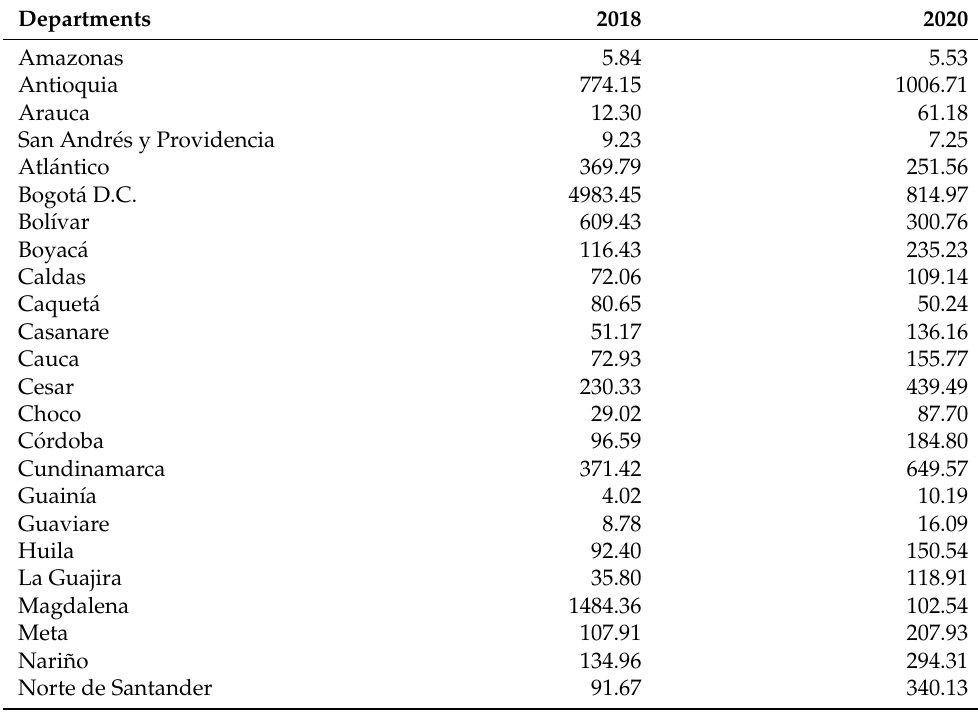
Table A4. CO 2 emissions (Gg) by departments from March to June 2018 and